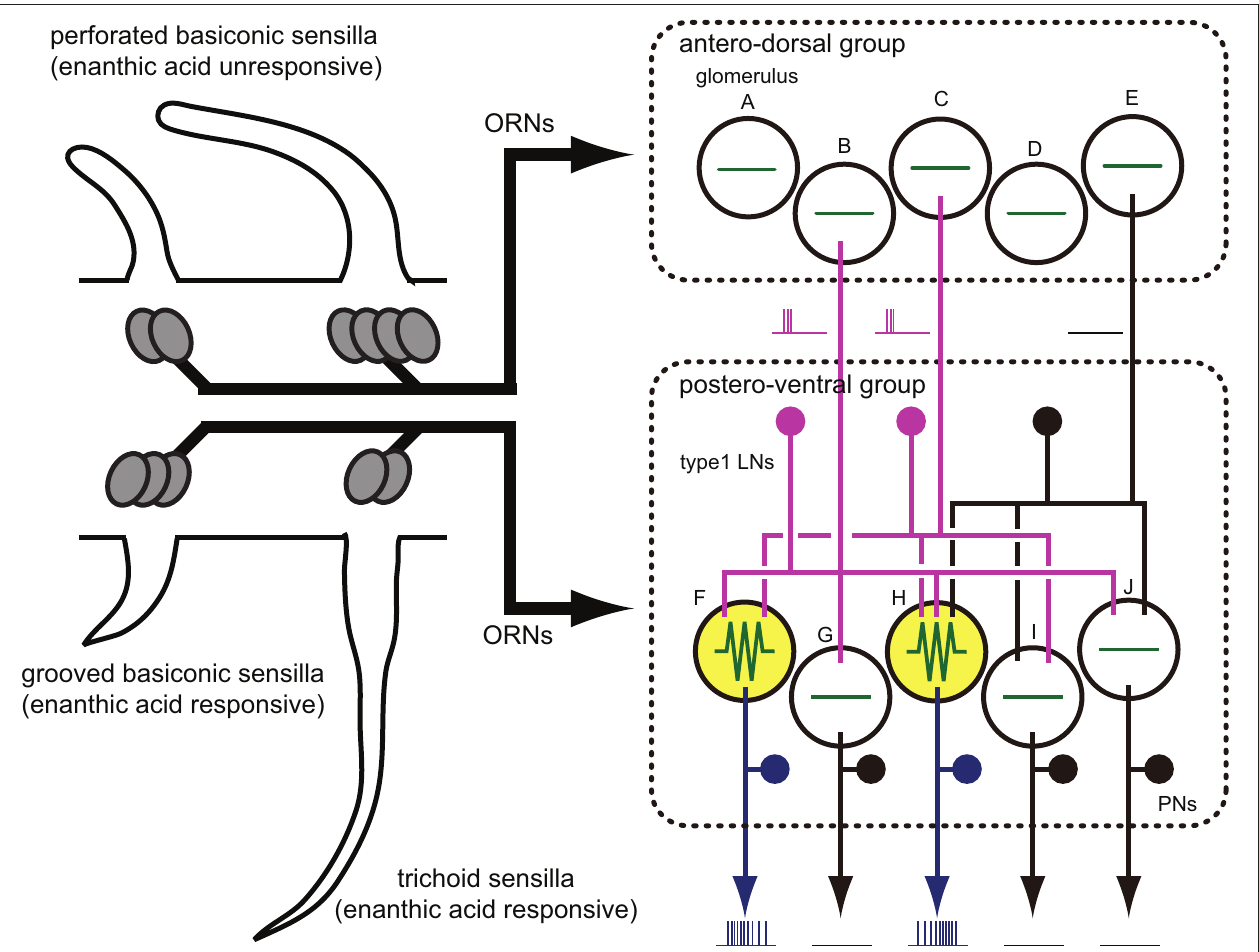
FIGURE 10 | A model of the neural basis of enanthic-acid processing. On the antennal surface of the cockroach, three distinct morphological types of olfactory sensilla have been identified; perforated basiconic, trichoid and grooved basiconic sensilla. Among these sensilla, enanthic-acid selectively received by olfactory receptor neurons (ORNs) housed in trichoid and grooved basiconic sensilla (Fujimura et al., 1991). Our anatomical study revealed that ORNs in trichoid and grooved basiconic sensilla selectively project to glomeruli of the postero-ventral group (Watanabe et al., 2012). Therefore, information of enanthic acid is mainly represented in glomeruli of the postero-ventral group. In fact, VSD imaging revealed that enanthic acid generated synchronized potentials only in glomeruli of the postero-ventral group. The cockroach AL consists of about 300 GABAergic local interneurons, 300 projection neurons, and 205 glomeruli (Boeckh and Tolbert, 1993; Watanabe et al., 2010). In this model, we simplify the cockroach AL as 3 GABAergic local interneurons (type-1 LNs), five uniglomerular projection neurons (PNs)